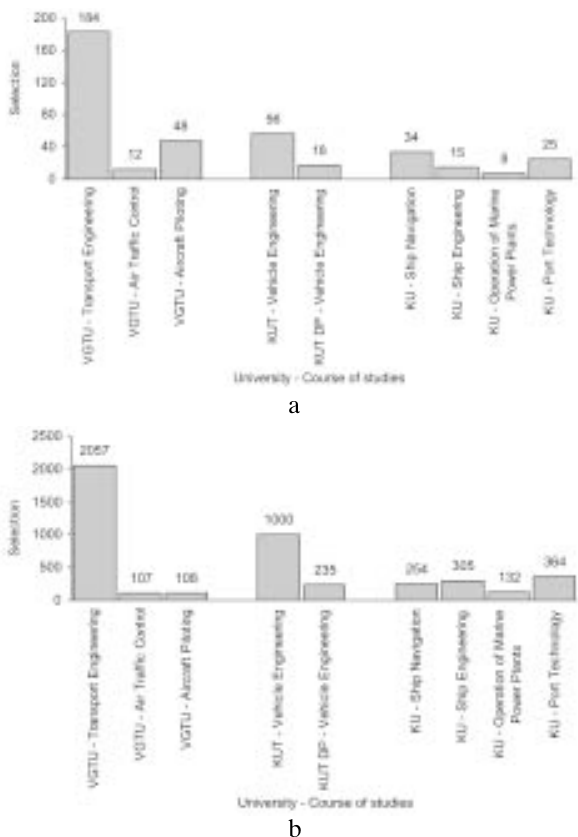
Fig 6. Popularity of courses of full-time studies in transport